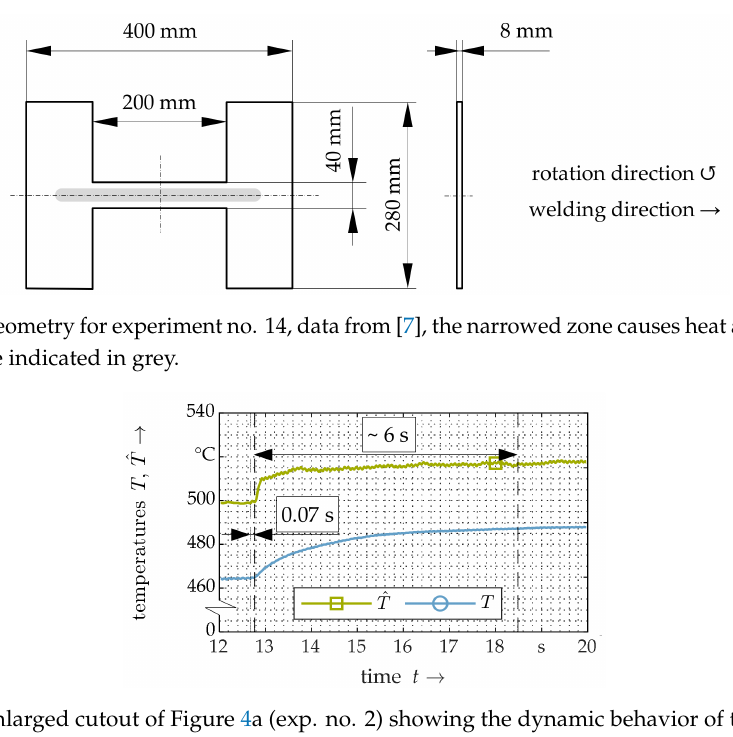
Figure A4. Enlarged cutout of Figure 4a (exp. no. 2) showing the dynamic behavior of the measured temperature T (blue circle) and the calculated temperature ˆ T (green square) for a stepwise increase of the RPM-rate n set